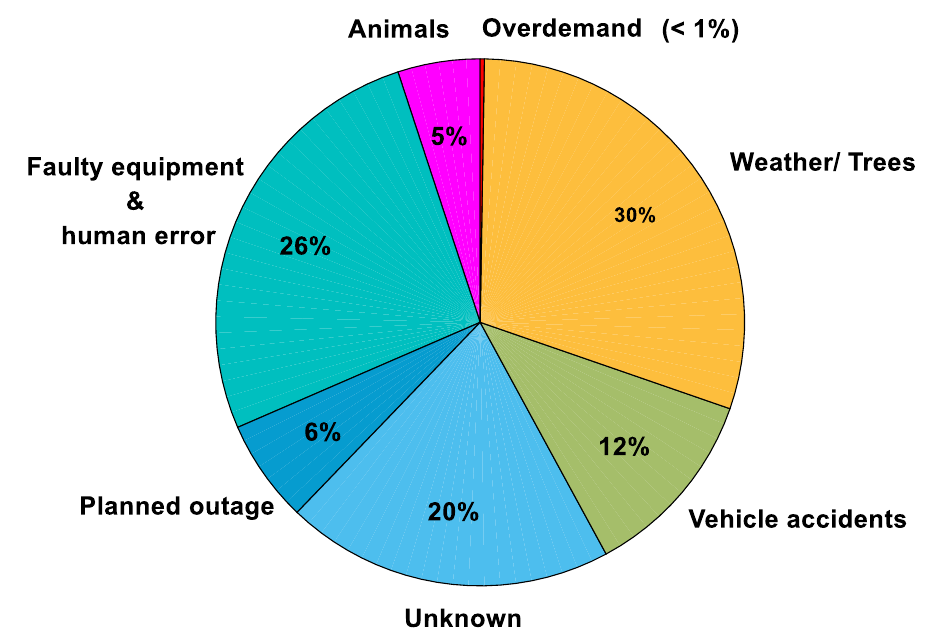
Figure 4. Major electric power system blackout causes